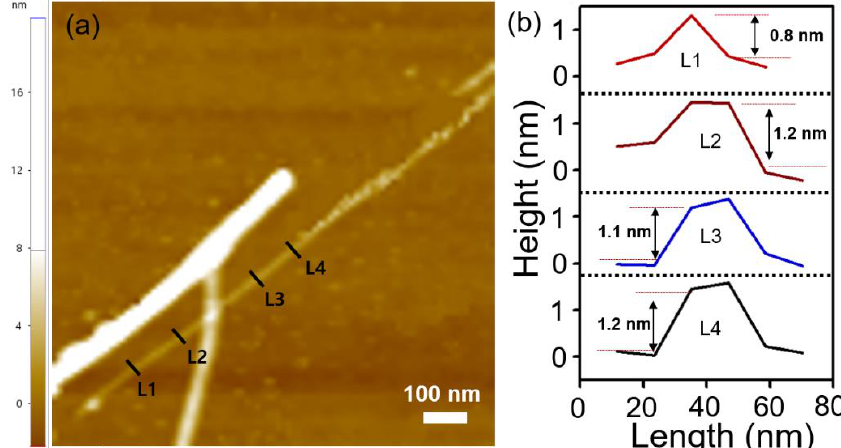
Figure 4. ( a ) AFM image of the V 2 Se 9 nanoribbon on the 300 nm SiO 2 /Si substrate. The inset shows an illustration of the V 2 Se 9 nanoribbon. ( b ) Line-profiles of the V 2 Se 9 nanoribbon as marked L1, L2, L3, and L4 in Figure 4a.